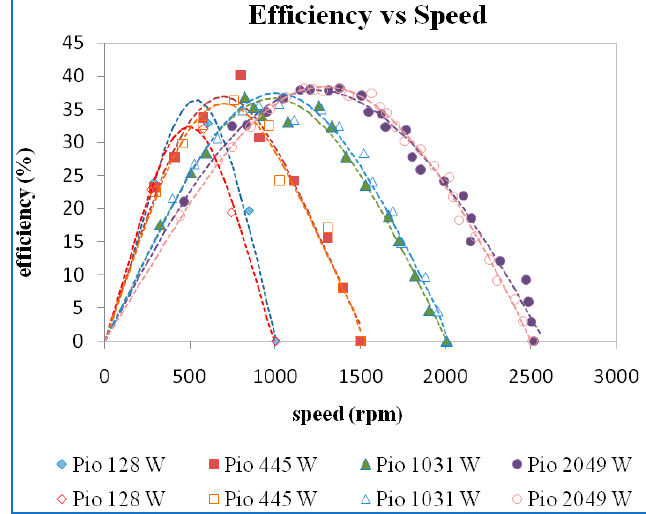
Figure 7. Efficiency vs. speed at a guide vane opening of 10 mm.